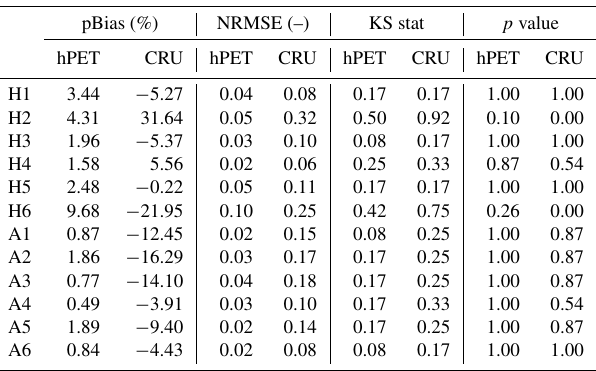
Figure 7. Single-point locations selected for global evaluation for humid and arid climate locations based on the aridity index data from the Consultative Group on International Agricultural Research (CGIAR; Trabucco and Zomer, 2018). Table 1. The pBias, NRMSE, and Kolmogorov–Smirnov (KS) test values between stoPET and hPET, as well as between stoPET and CRU, for the humid and arid locations on six continents as indicated in Fig. 7.